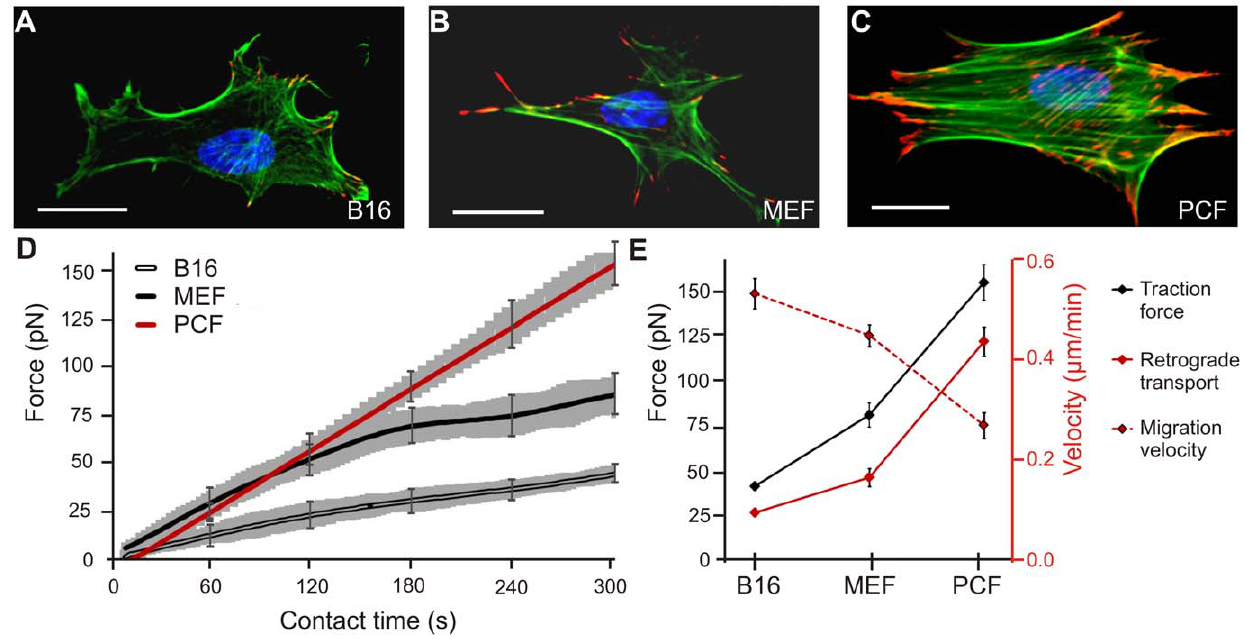
Figure 5. Comparison of different cell types. A) to C) Fluorescent labeling of the nucleus (blue) actin cytoskeleton (green), and vinculin (red) of mouse B16F1 melanoma cells (B16), mouse embryonic fibroblasts (MEF) and primary chicken fibroblasts (PCF) (scale bars 20 m m). D) Averaged force- time curves for the three cell lines (s.e.m. is marked in gray and only exemplified for selected time points) using 4.5 m m beads with 80% FN surface coverage. E) Correlation of traction forces, retrograde transport velocities, and migration velocities for the different cell types. A linear correlation for force and retrograde transport is revealed and is concomitant with a reciprocal correlation for migration velocity.